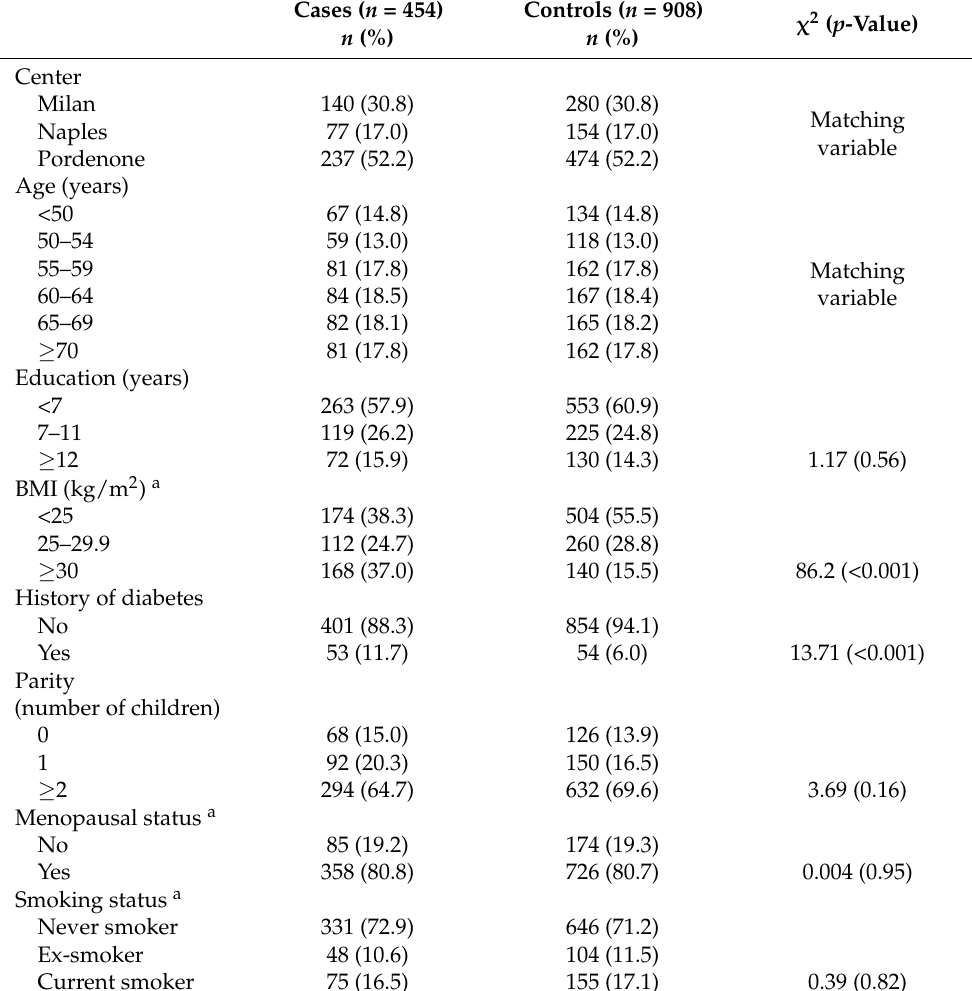
Table 1. Distribution of cases with endometrial cancer cases and matched controls according to selected covariates. Italy,